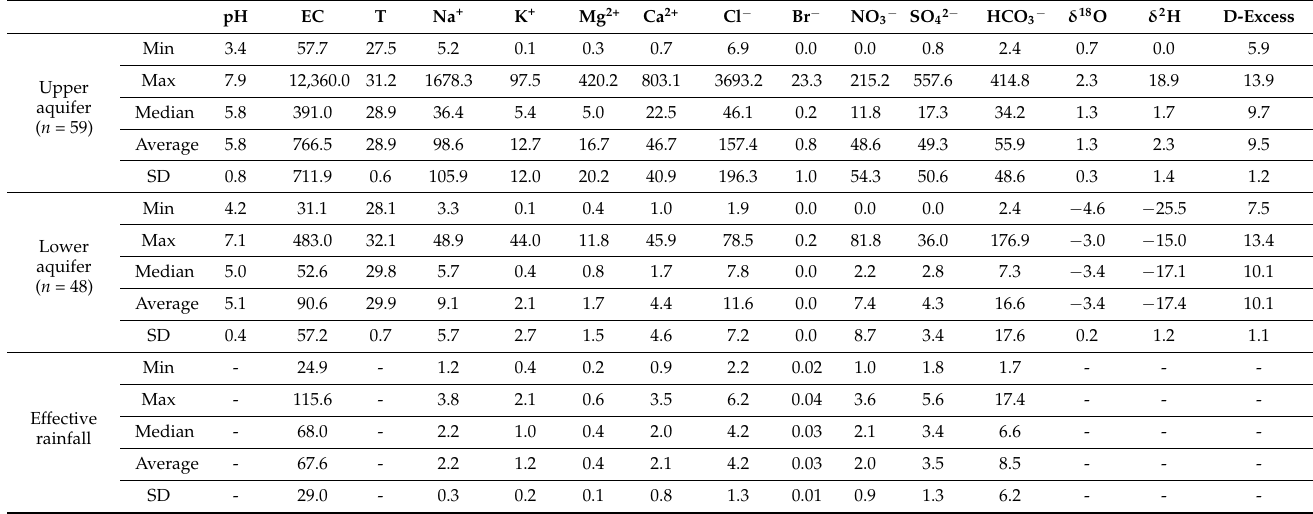
Table 1. Statistical description of field and laboratory